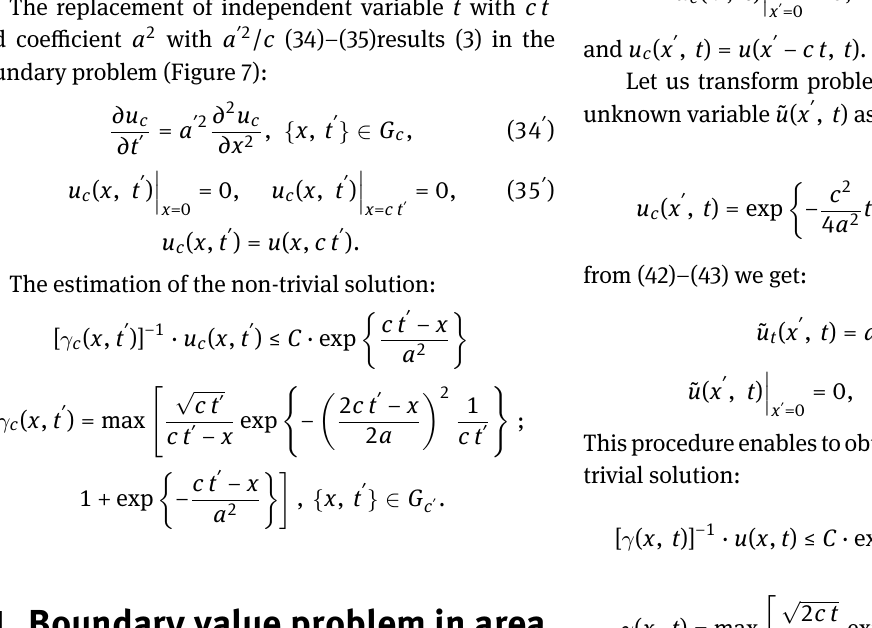
Figure 7: Area G c . Graphs of the line L and sets G ′ The replacement of independent variable t with c t ′